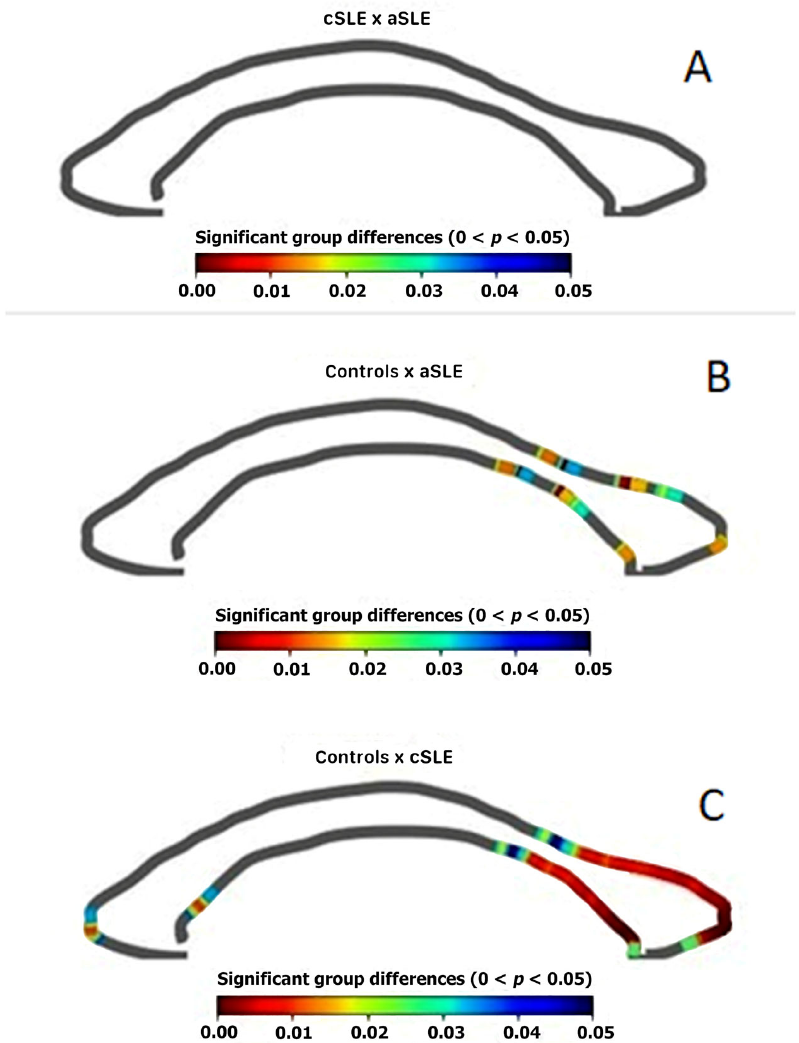
Figure 2. Comparison of mid ‐ sagittal area of corpus callosum between the groups, showing a reduced area in the posterior region of the corpus callosum when comparing the controls and cSLE ( C ), the controls and aSLE ( B ), and similar areas in cSLE and aSLE ( A ). We observed significantly lower FA values in the total corpus callosum when comparing the aSLE patients to the controls, as well as higher MD and RD values (Table 2). No differences between the cSLE patients and the controls was observed.